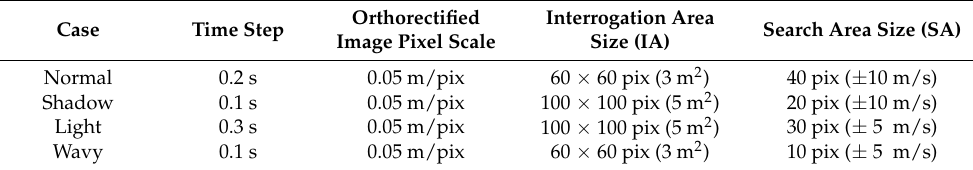
Table 4. The details of the settings of the LSPIV analysis. Velocities were calculated as the average of the velocities of all frames after filtering out those with correlation coefficients less than